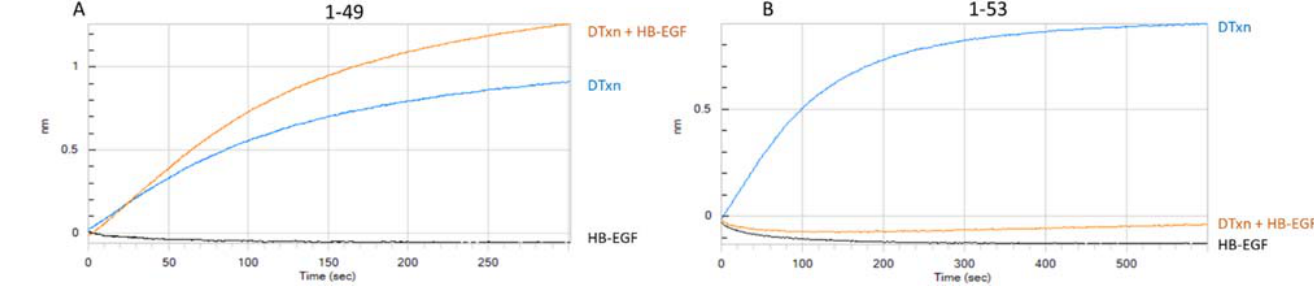
Figure 1. Inhibition of mAb binding to DTxd by HB-EGF. BLI signal upon association of DTxn to mAb 1-49 ( A ) or mAb 1-53 ( B ) immobilized onto the biosensor. Curves depict the association of: DTxn alone (blue); DTxn that has been pre-incubated with HB-EGF (60 min, 37 °C) (orange); HB-EGF alone (black).